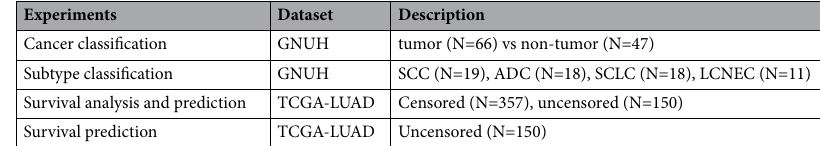
Table 1. Dataset description for experiments on several applications of slide-based